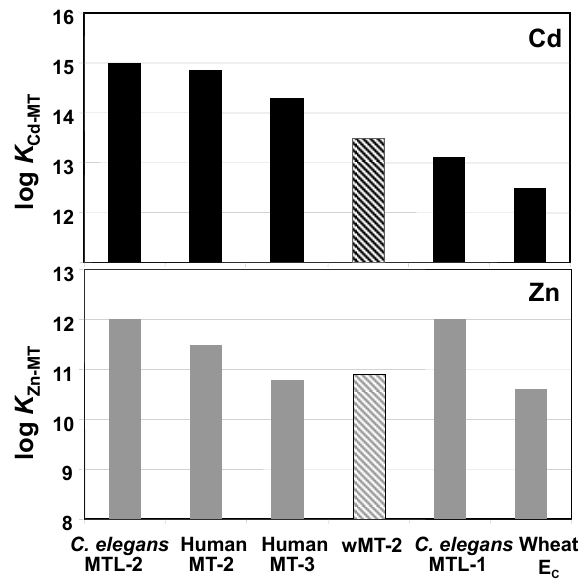
Figure 4. Comparison of stability constants determined by competition with 5F-BAPTA at pH 8.1 and I = 4 mM (10 mM Tris) [19,20,55,56]. The proteins are ordered by falling affinity for Cd(II). Hatched bars highlight wMT-2 data determined in the present study. Note that the scales do not start at 0.